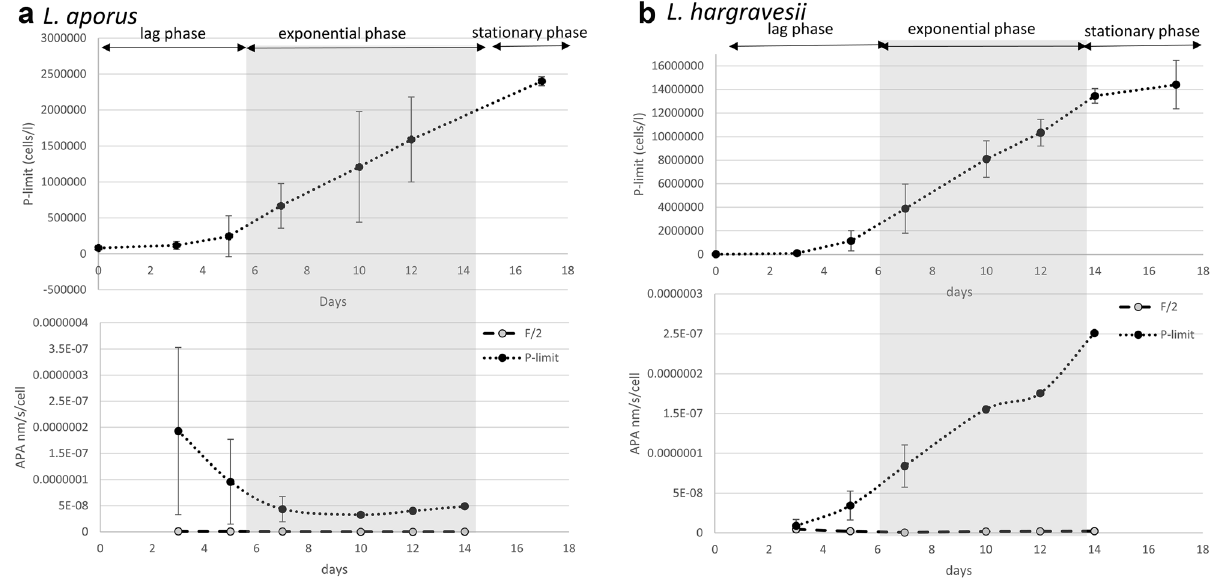
Figure 12. The dynamics of cellular APA of cultures in F/2 and P-limit medium across the growth curves of respective cultures in P-limit medium; ( a ) L. aporus , ( b ) L.